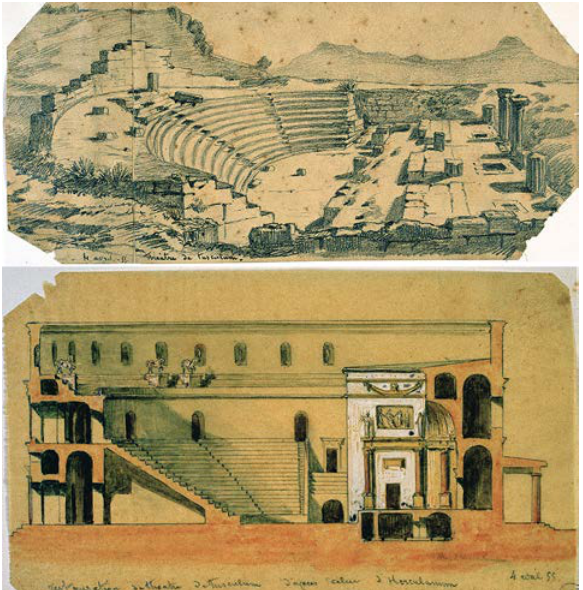
Figure 1. Two freehand drawings by Maurice Sand dated April 4, 1855. Perspective view of the theater (top); reconstructive section of the theater (bottom), based on the theater of Herculaneum